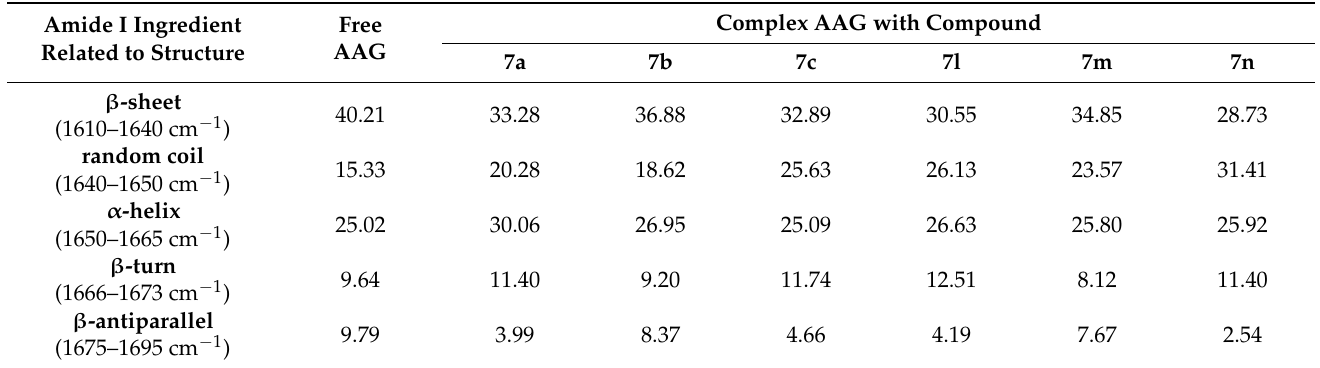
Table 14. Percentage of the secondary structure of free alpha-1-acid glycoprotein (AAG) and com- plexes with studied